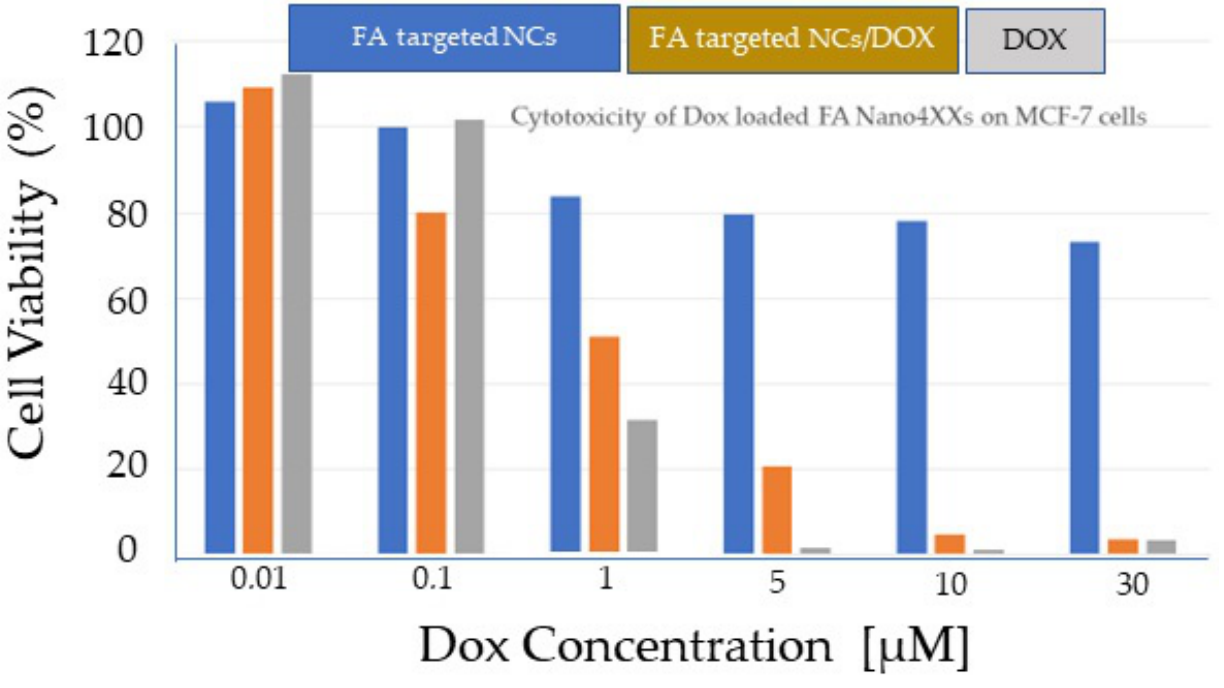
Figure 13. Cytotoxicity of F.A.-Nano4XX, FA-Nano4(Dox), and free DOX in MCF-7 cells repeated three times [5,18].